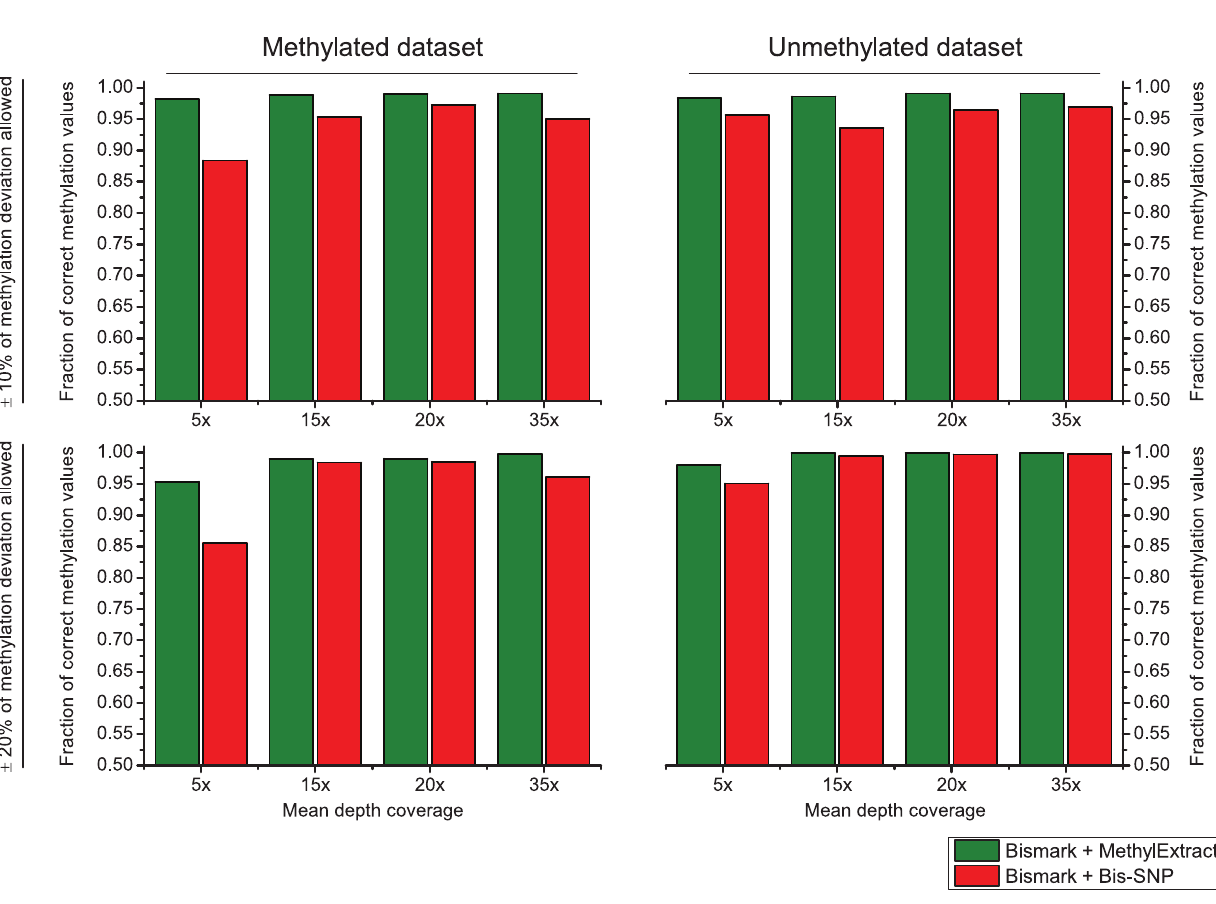
Supplementary Figure 1. Methylation profiling comparison MethylExtract and Bis-SNP using relaxed criterion. Both methods are compared in terms of fraction of correctly profiled CpG methylation values. The upper part of the graph shows the result allowing up to 10% deviation from the real methylation values, while the lower part shows the outcome increasing this range to 20%. The analyses were done for unmethylated and methylated datasets at four different coverages (5×, 15×, 20× and